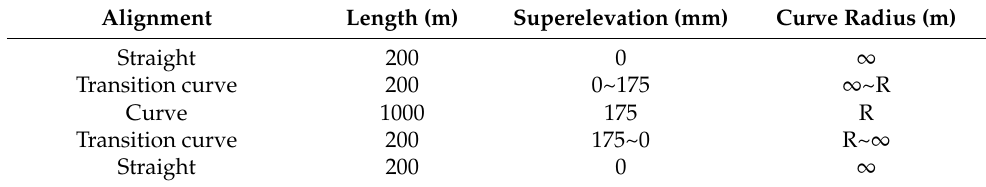
Table 2. Track alignment parameters.